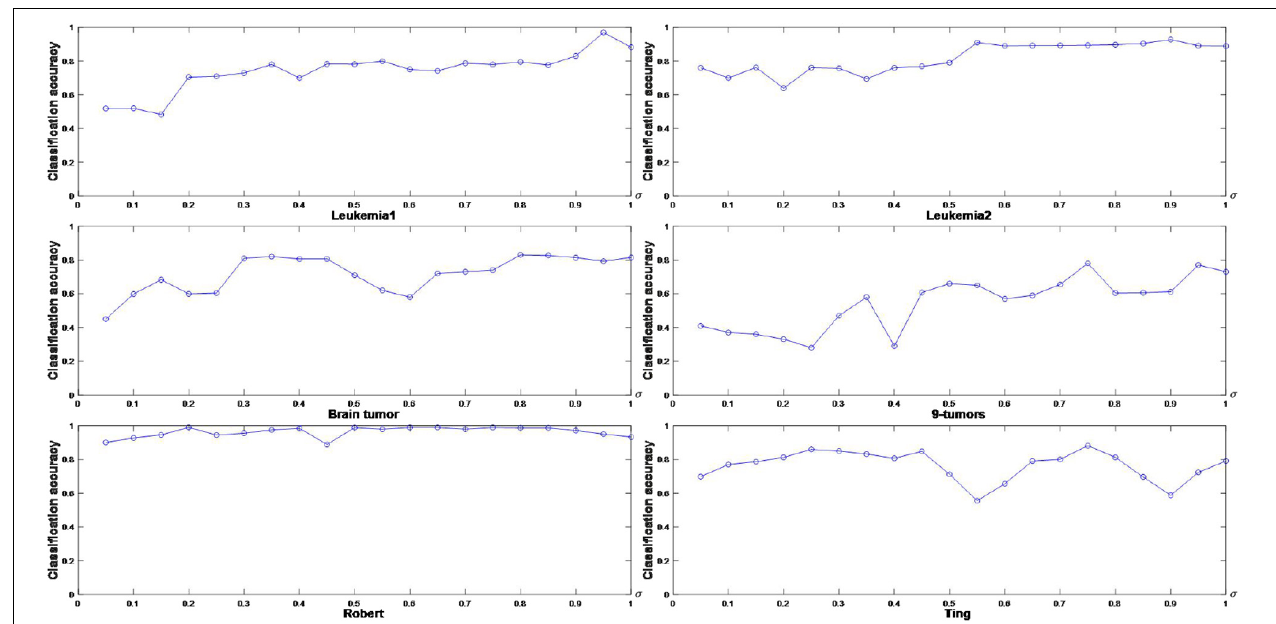
FIGURE 1 | Classification accuracy for six gene expression data sets with different values of σ